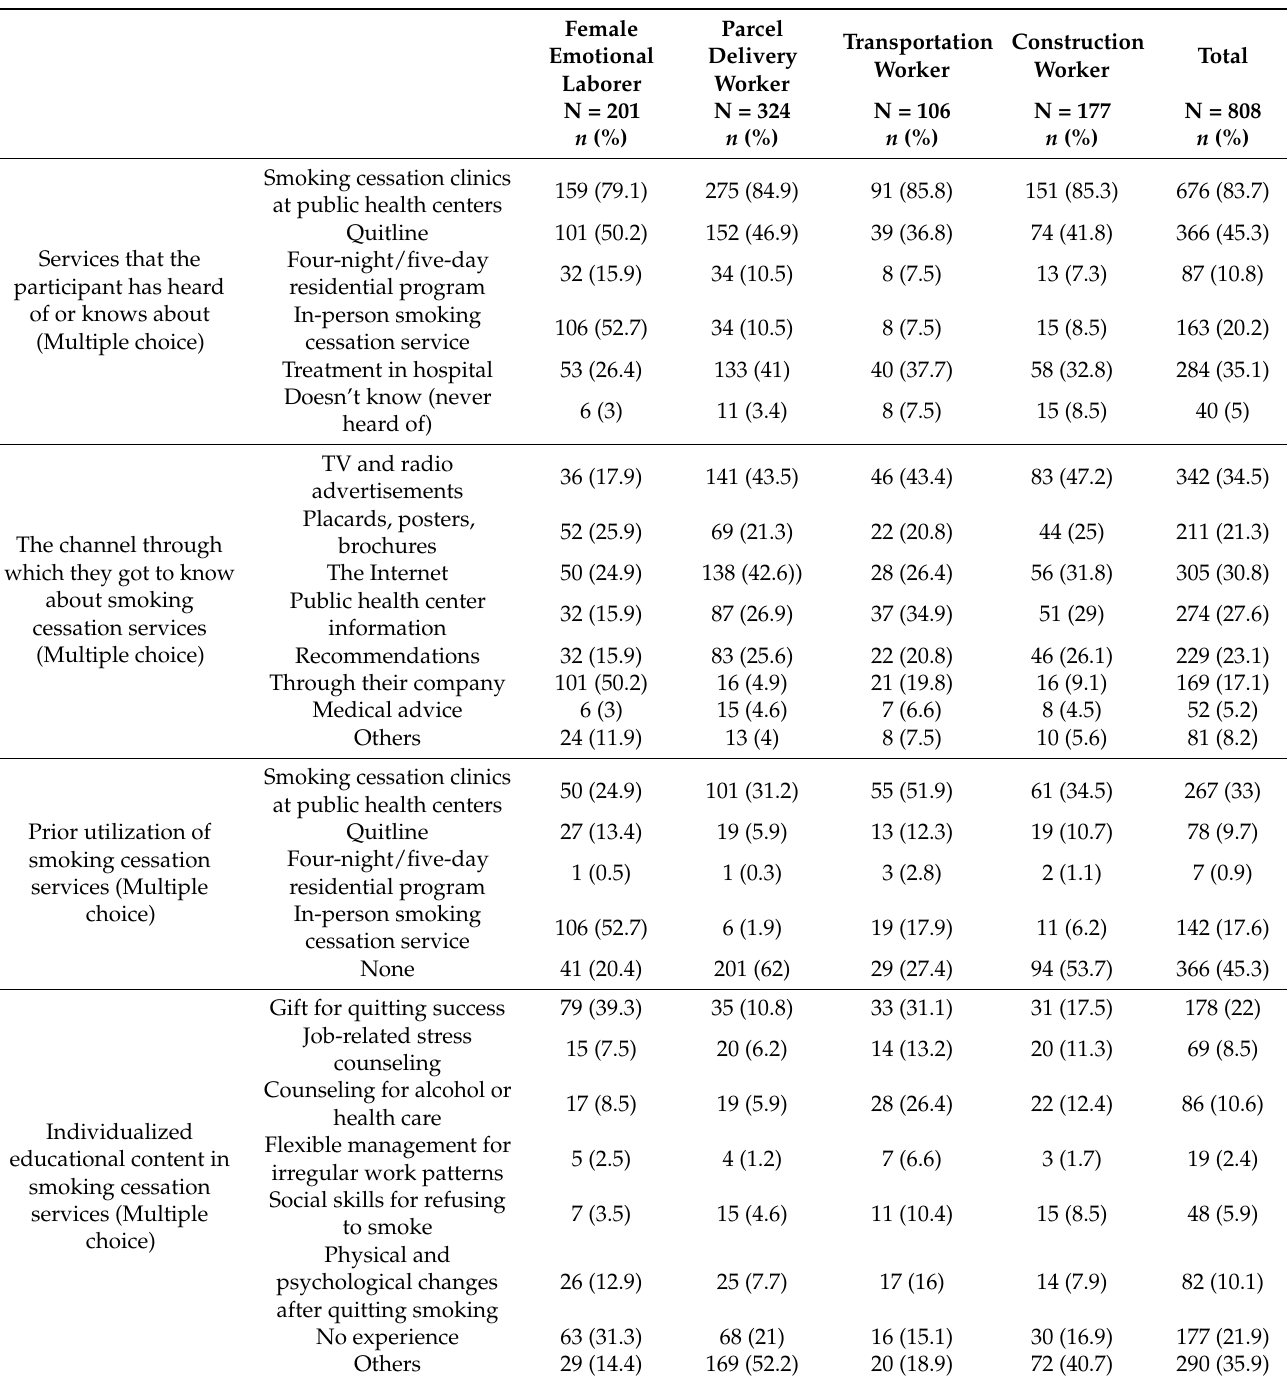
Table 3. Awareness of smoking cessation